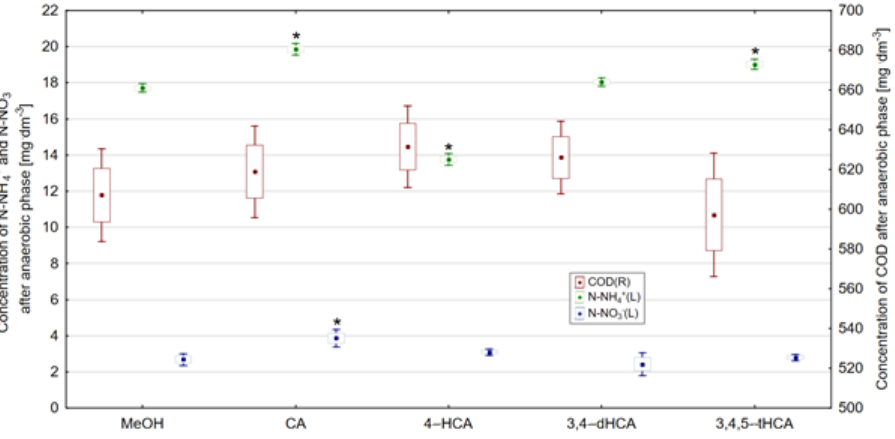
Figure 12. Concentration of N-NH 4 + , N-NO 3 − and COD after anaerobic phase, *—result differing with statistical significance at α = 0.05 in accordance with the control reactor (point—arithmetic mean, box—standard error, line—standard deviation).